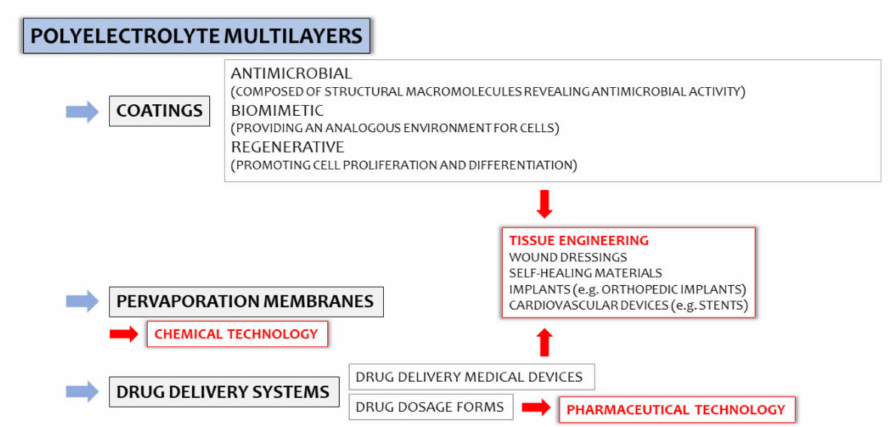
Figure 1. The applicability of polyelectrolyte multilayers (PEMs) in the biomedical and pharmaceuti- cal